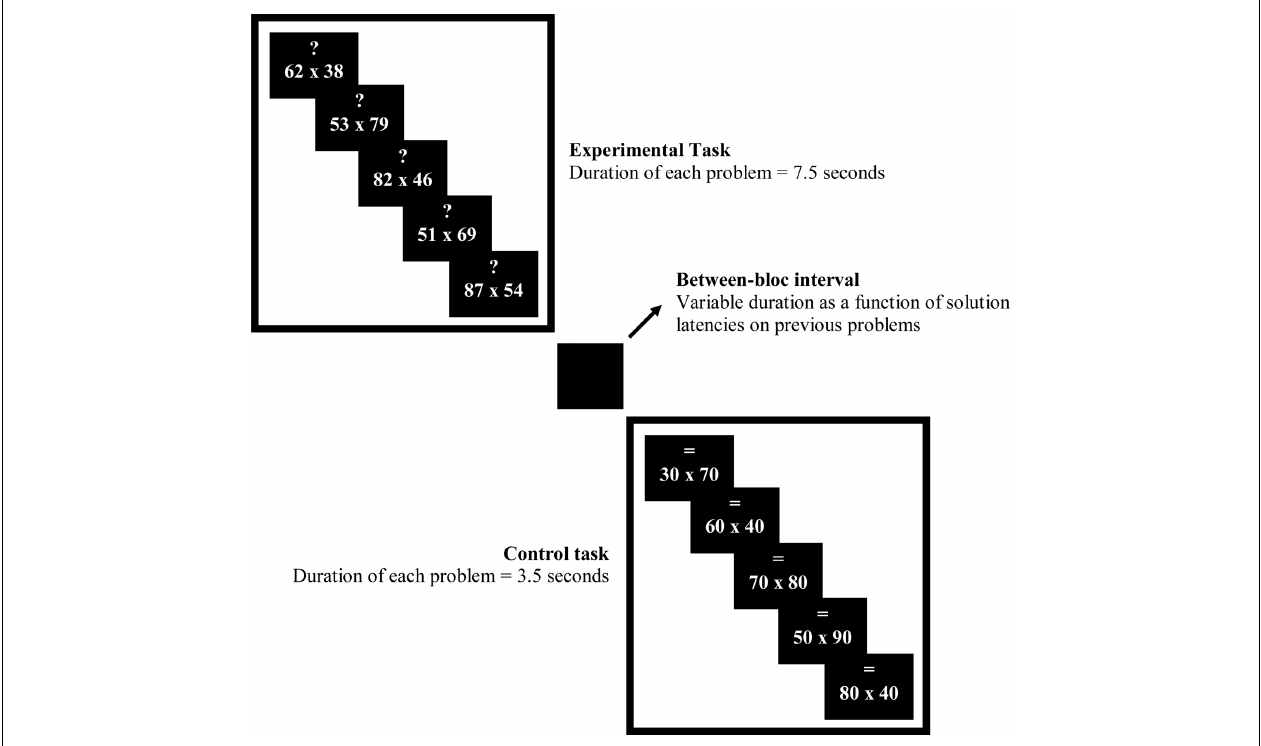
FIGURE 1 | Experimental